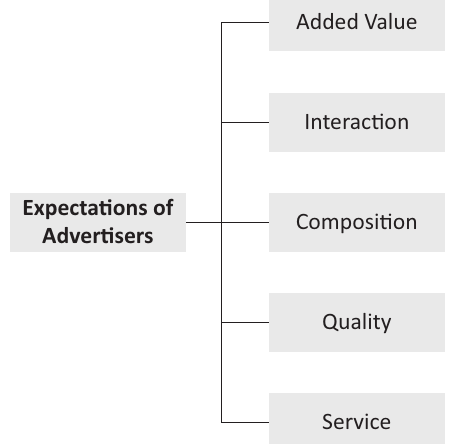
Figure 1. Advertisers’ expectations towards publishers’ products.